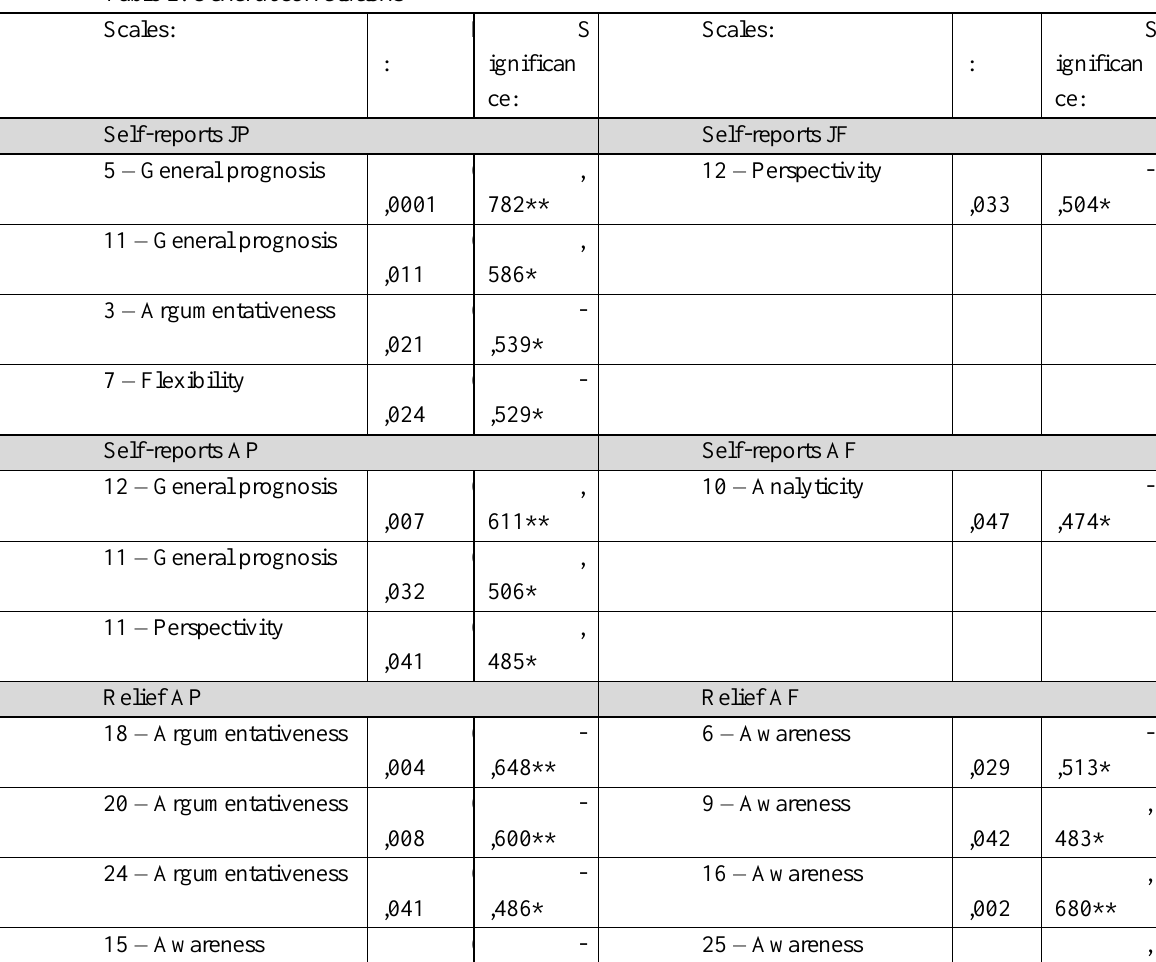
Table 2. General